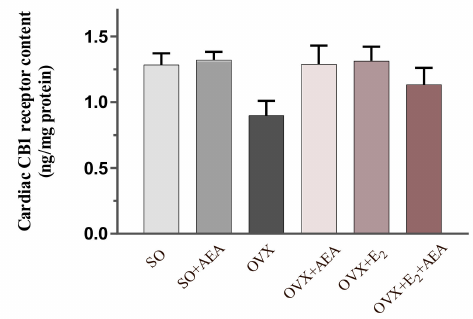
Figure 3. E ff ects of anandamide and estrogen treatment on cardiac CB1 receptor content in SO and OVX animals (expressed as ng / mg protein). Results are shown as means ± S.E.M; n = 5–11; CB1 receptor = cannabinoid 1 receptor .